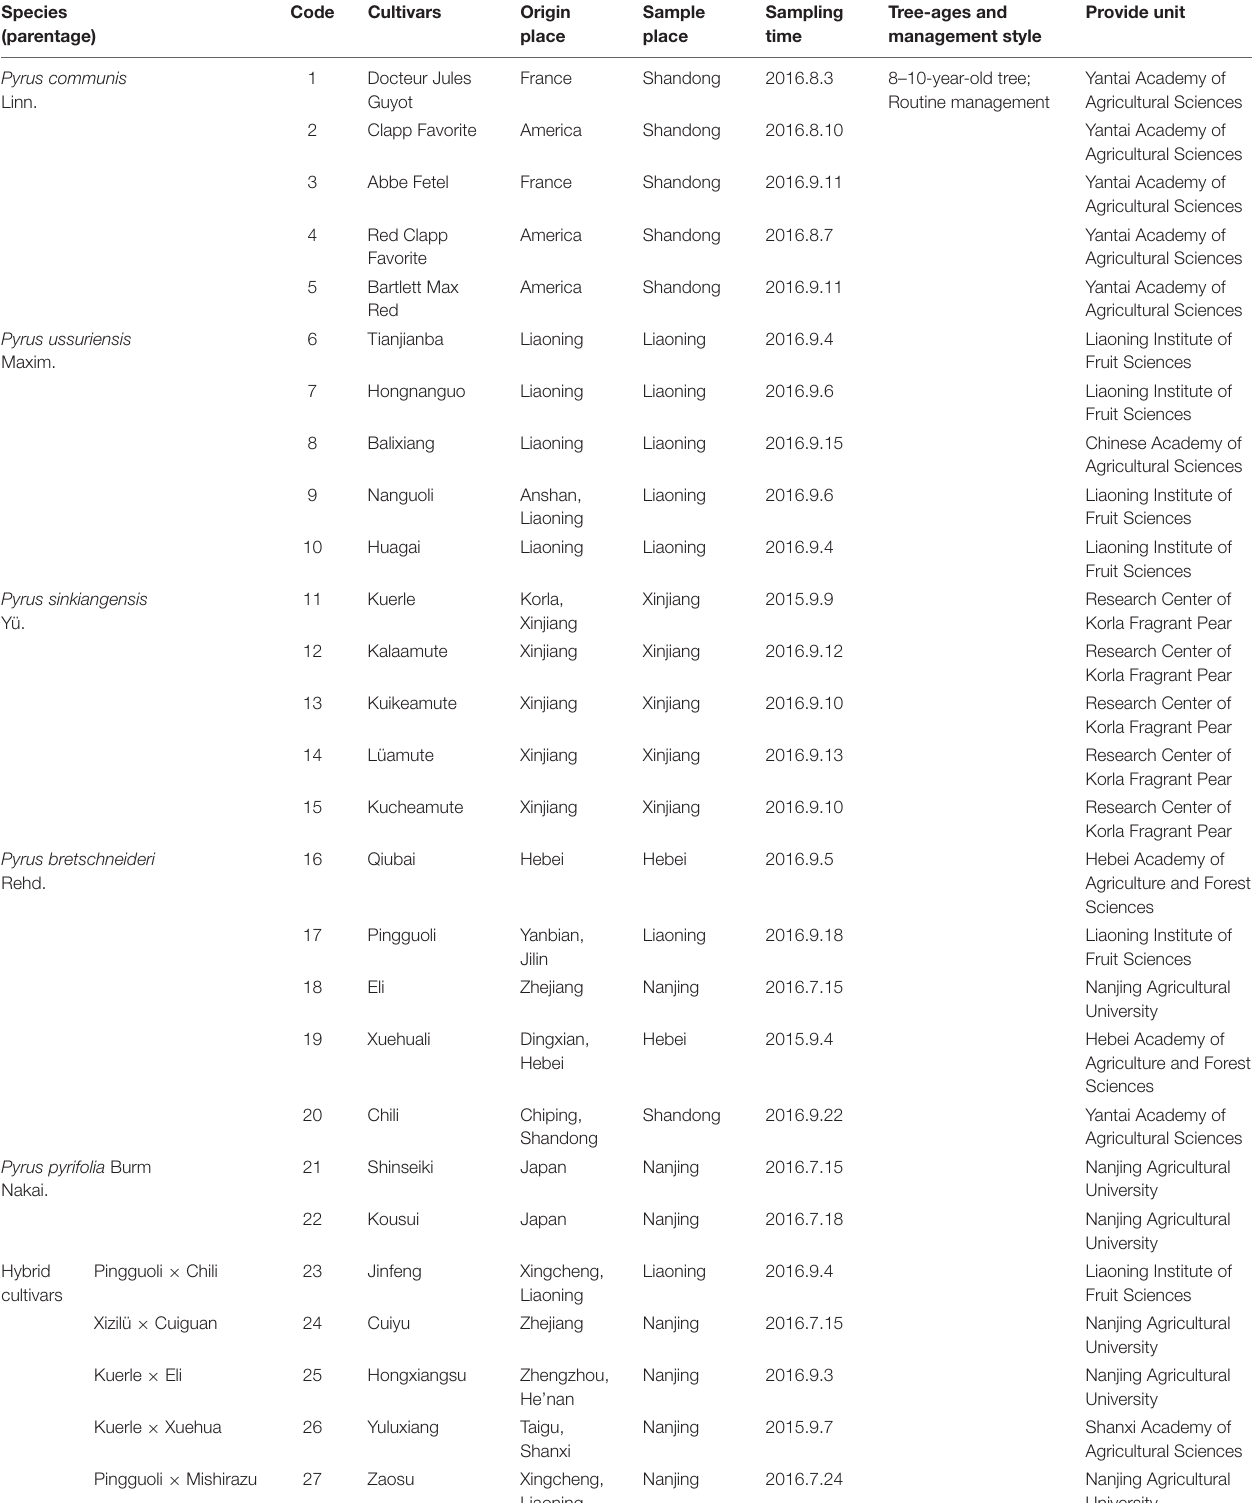
TABLE 1 | Cultivars of pears used in the study. Species